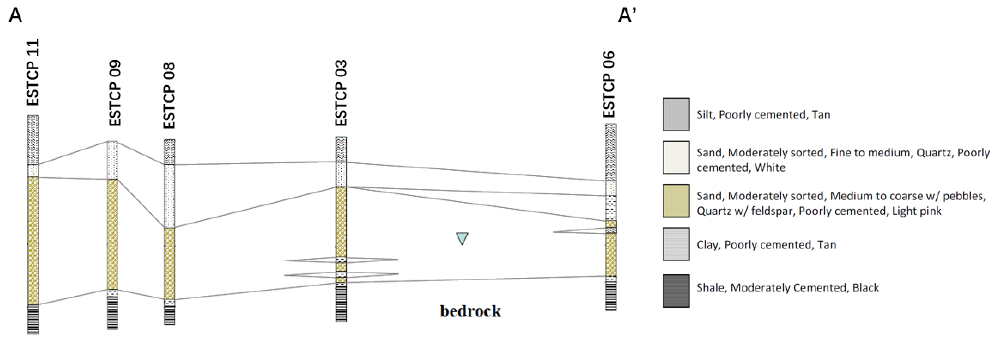
Figure 2. Geologic cross-sections through the demonstration location in Figure 1b [17].